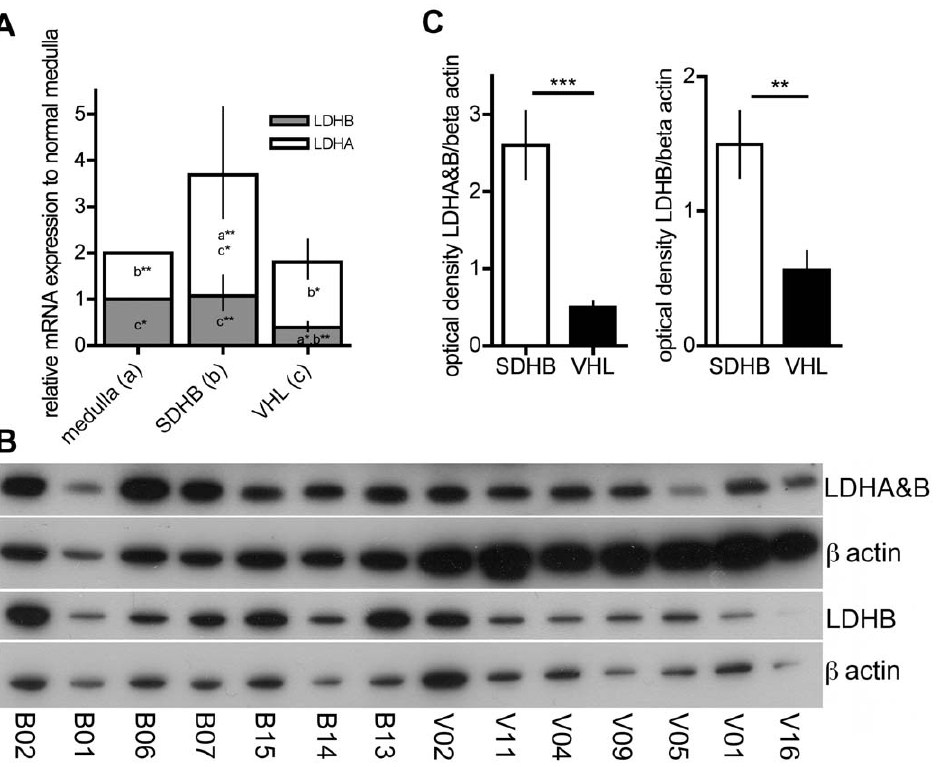
Figure 3. Lactate dehydrogenase expression. A Expression of LDHA and LDHB mRNA in SDHB- and VHL-derived PHEO/PGL tissues relative to normal adrenal medulla. A letter and asterisk(s) within each column indicate significant expression differences between the groups were appropriate (a: significantly different from normal medulla, b: significantly different from SDHB, c: significantly different from VHL, *: p , 0.05, **: p , 0.01). B Western blot for LDHA and B as well as LDHB for SDHB-derived tumors (left) and VHL-derived tumors (right). C Optical density of bands as assessed with image J software for LDHA and B as well as LDHB from western blots shown in B . Significant differences are indicated by *** for p , 0.001 and ** for p ,